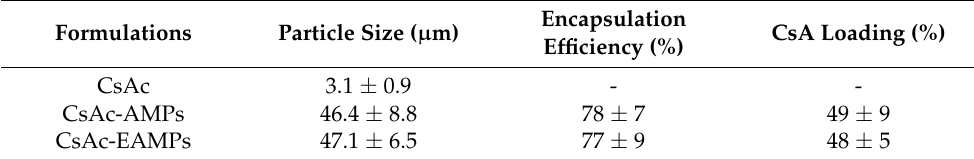
Table 1. Physicochemical characteristics of CsA formulations.